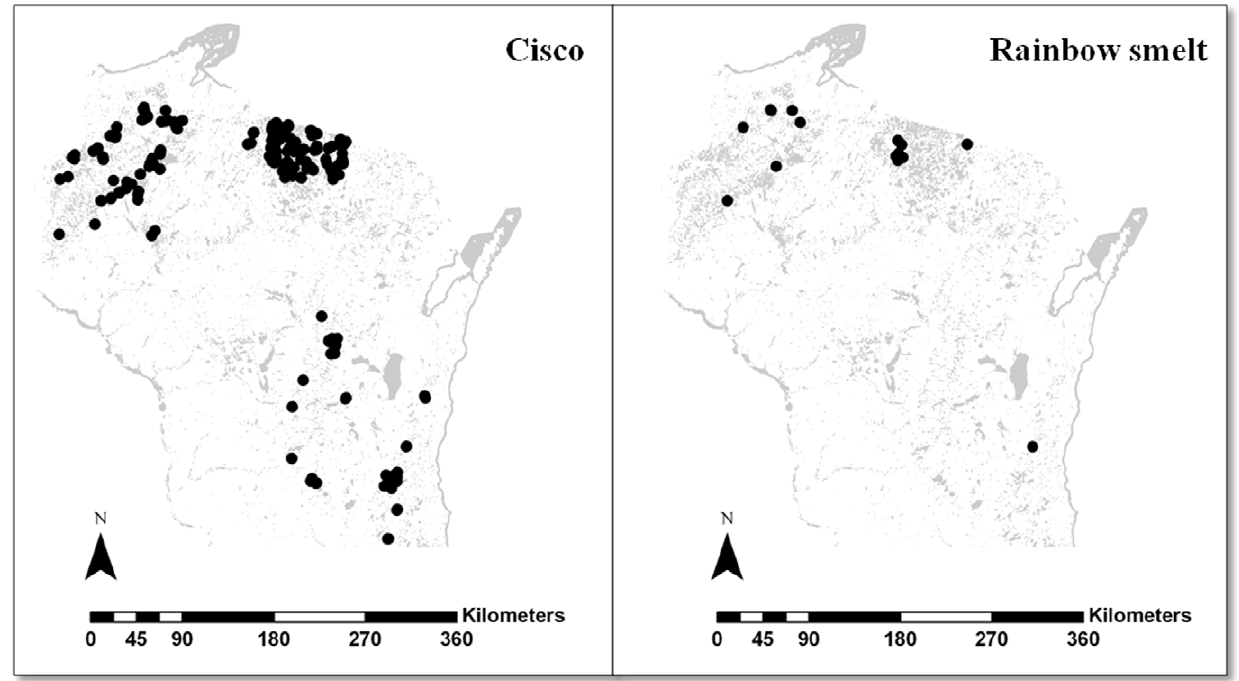
Figure 1. Species occurrence in Wisconsin. Current occurrence of a) cisco and b) rainbow smelt in Wisconsin lakes. Currently, cisco are present in 184 lakes and rainbow smelt occur in 24 lakes.